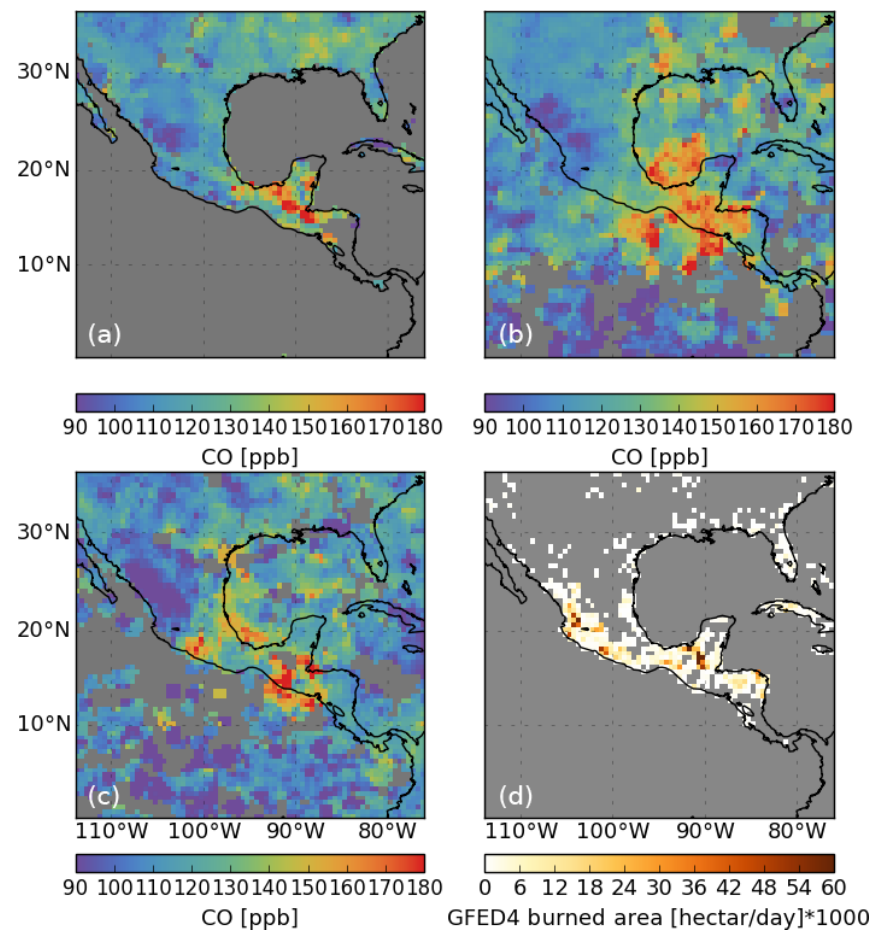
Figure 3. SCIAMACHY CO retrievals under clear-sky (a) , low-cloud (b) and medium–high cloud (c) atmospheric condition as well as daily GFED4 Burned Area (d) averaged from 15 March to 15 May 2005 over Mexico and Central America. The resolution of the plot is 0.5 ◦ in latitude and longitude and the data are oversampled using a radius of